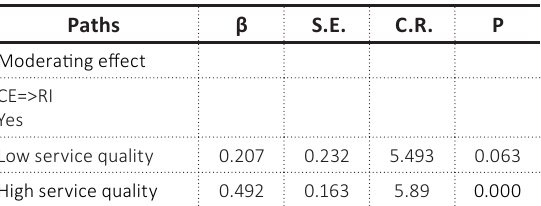
Table 4. Moderating effect of service quality